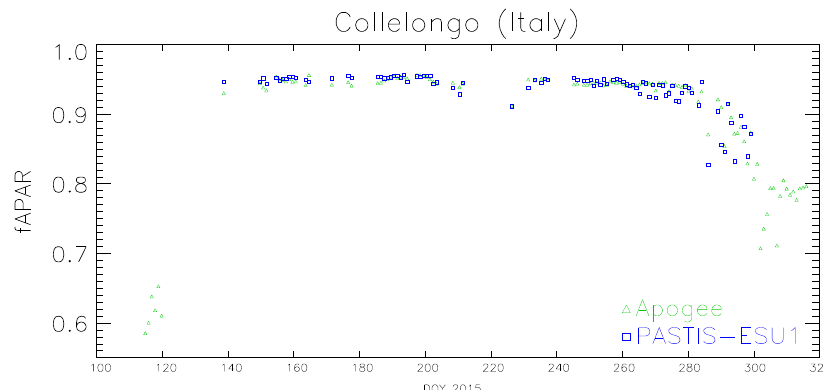
Figure 4. Temporal course of fAPAR APOGEE (green triangles) and fAPAR PASTIS-ESU1 (blue squares) at ESU 1 during 2015 (DOY = day of year).